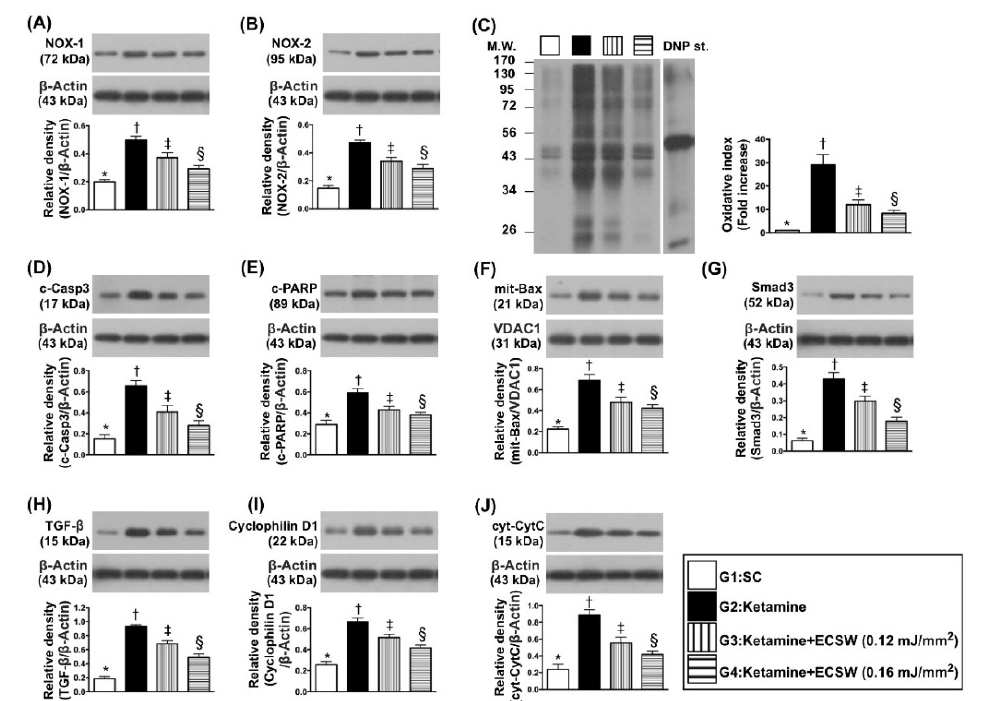
Figure 9. ECSW suppressed the protein levels of oxidative stress, apoptosis, fibrosis and mitochondrial damage in rat urinary bladder by day 42 after ketamine administration. ( A ) Protein expression of NOX-1, * vs. other groups with different symbols (†, ‡, §), p < 0.0001. ( B ) Protein expression of NOX-2, * vs. other groups with different symbols (†, ‡, §), p < 0.0001. ( C ) The oxidized protein expression, * vs. other groups with different symbols (†, ‡, §), p < 0.0001 (Note: The left and right lanes shown on the upper panel represent protein molecular weight marker and control oxidized molecular protein standard, respectively). M.W. = molecular weight; DNP = 1–3 dinitrophenylhydrazone. ( D ) Protein expression of cleaved caspase 3 (c-Casp3), * vs. other groups with different symbols (†, ‡, §), p < 0.0001. ( E ) Protein expression of cleaved Poly ADP-ribose polymerase (c-PARP), * vs. other groups with different symbols (†, ‡, §), p < 0.0001. ( F ) Protein expression of mitochondrial (mit)-Bax, * vs. other groups with different symbols (†, ‡, §), p < 0.0001. ( G ) Protein expression of Smad3, * vs. other groups with different symbols (†, ‡, §), p < 0.0001. ( H ) Protein expression of transforming growth factor (TGF)-ß, * vs. other groups with different symbols (†, ‡, §), p < 0.0001. ( I ) Protein expression of cyclophilin D, * vs. other groups with different symbols (†, ‡, §), p < 0.0001. ( J ) Protein expression of cytosolic cytochrome c (cyt-CytC), * vs. other groups with different symbols (†, ‡, §), p < 0.0001. All statistical analyses were performed by one-way ANOVA, followed by Bonferroni multiple comparison post hoc test ( n = 6 for each group). Symbols (*, †, ‡, §) indicate significance (at 0.05 level). ECSW = extracorporeal shock wave.